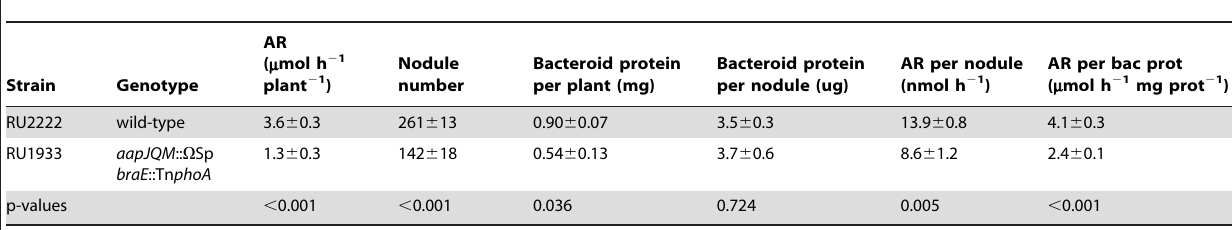
Table 4. Symbiotic properties of 4 week old bean